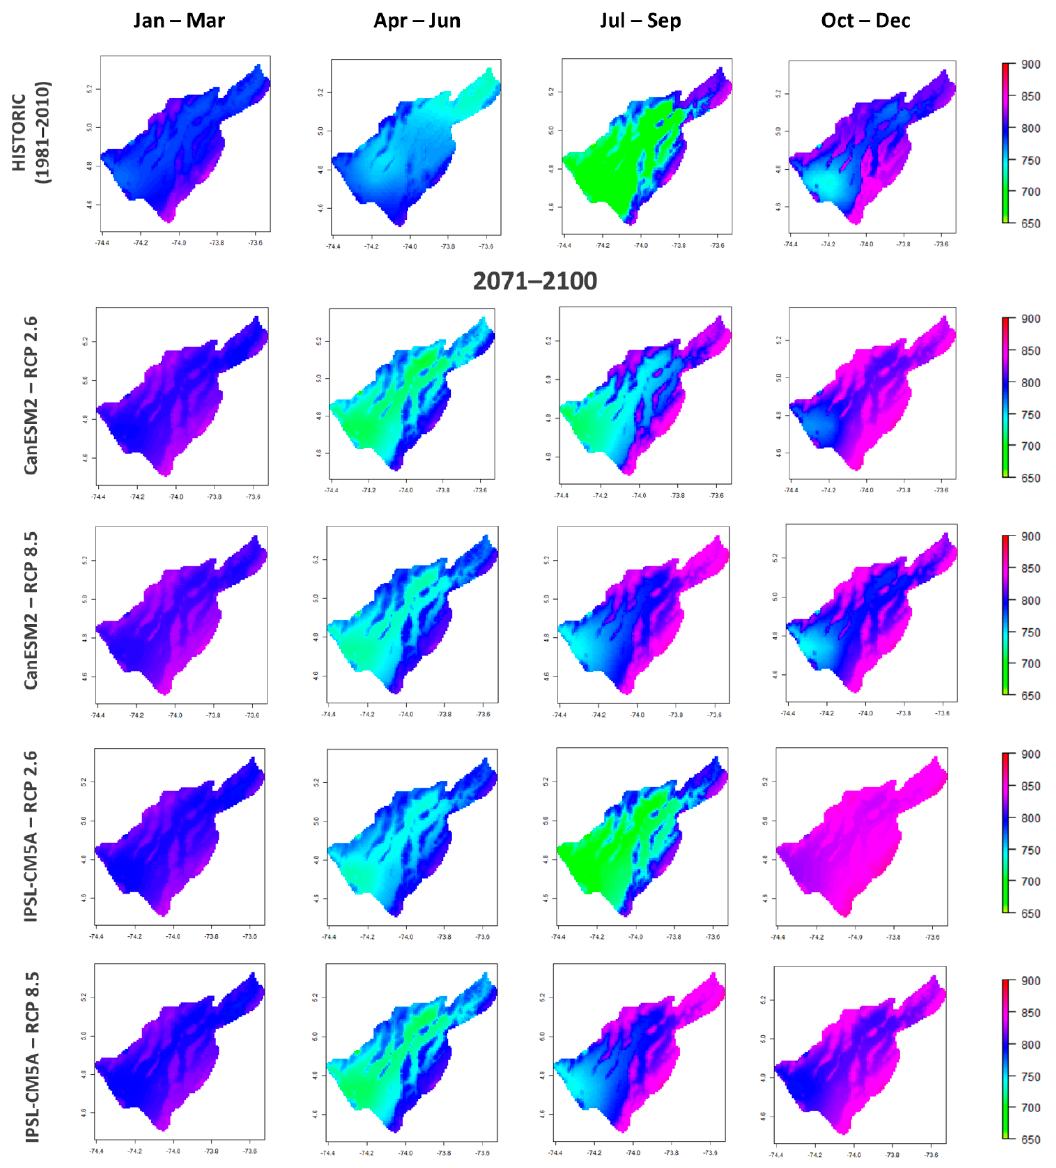
Figure B8. Soil Moisture 2071–2100 Figure A12. Soil Moisture